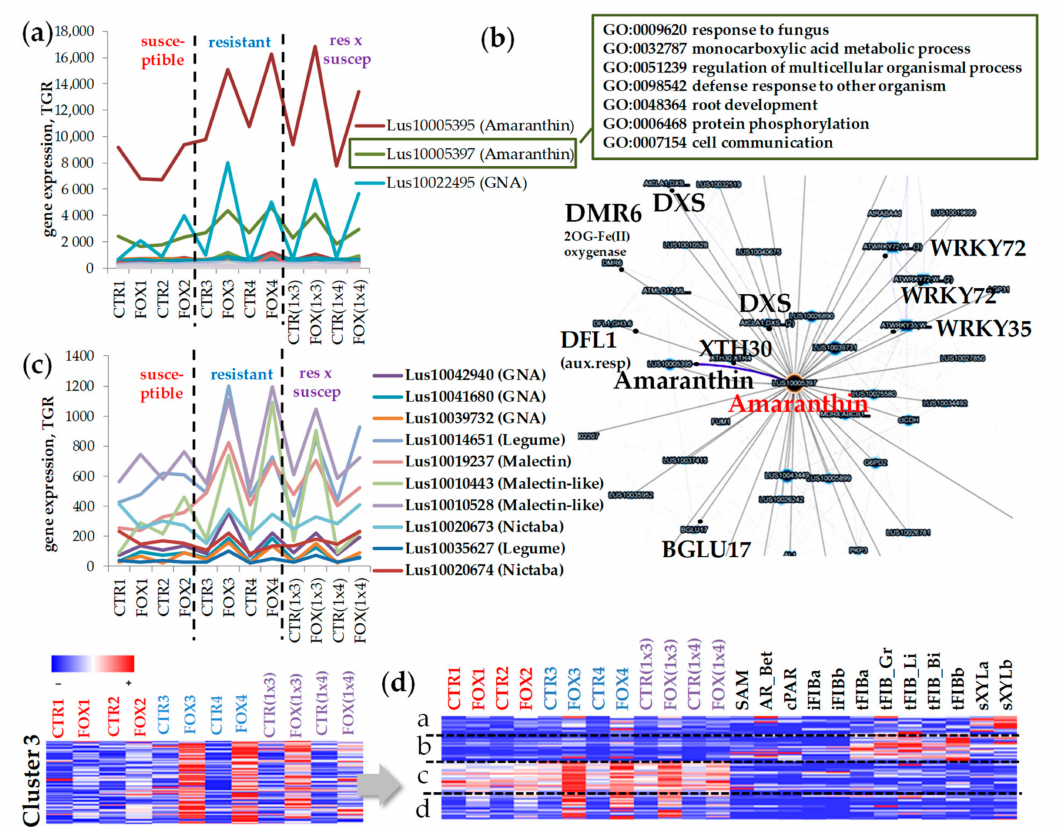
Figure 6. ( a ) The expression of lectin genes upregulated in the root tips during Fusarium oxysporum infection to varying degrees in different flax genotypes. ( b ) The coexpression network for Lus10005397 (Amaranthin family), its co-expressed genes, and their gene ontology (GO, for orthologous genes in Arabidopsis). ( c ) The expression profile of lectin genes expression of which is more activated in the resistant cultivars. ( d ) Cluster analysis of 70 genes upregulated in root tips of susceptible cultivars to a lesser extent as compared to resistant cultivars after inoculation with F. oxysporum for root and stem samples. Options for clustering: k-means (4 clusters) method, a distance measured by Pearson correlation, local (auto) scale. The color gradient of the red-blue heatmap reflects TGR values from minimum (blue) to maximum (red) in the row. CTR1,2,3,4,(1x3),(1x4)—untreated root tips